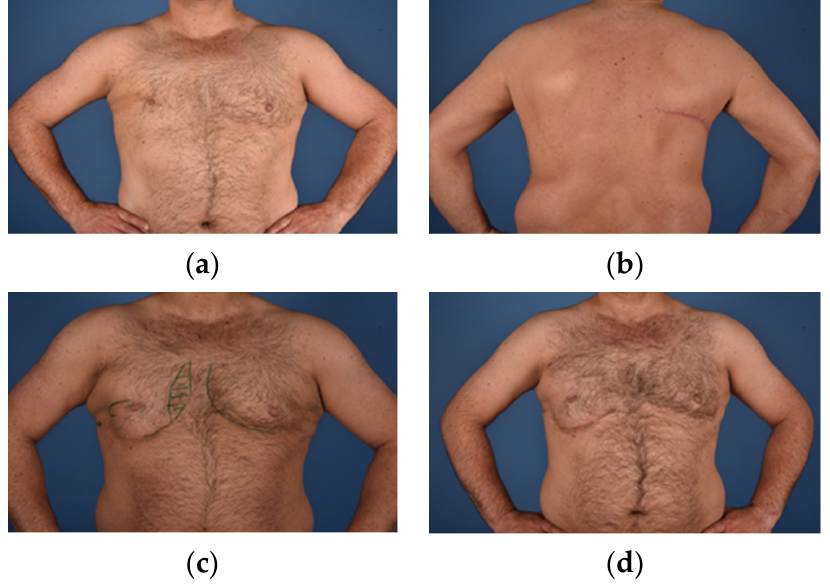
Figure 1. ( a ) = Male patient (40) pre-operatively with Grade II deformity; ( b ) = LDF donor site; ( c ) = Recipient site after LDF reconstruction (green lines mark fat grafting recipient sites); ( d ) = Recipient site after flap reconstruction and 2 × autologous free fat transfer.